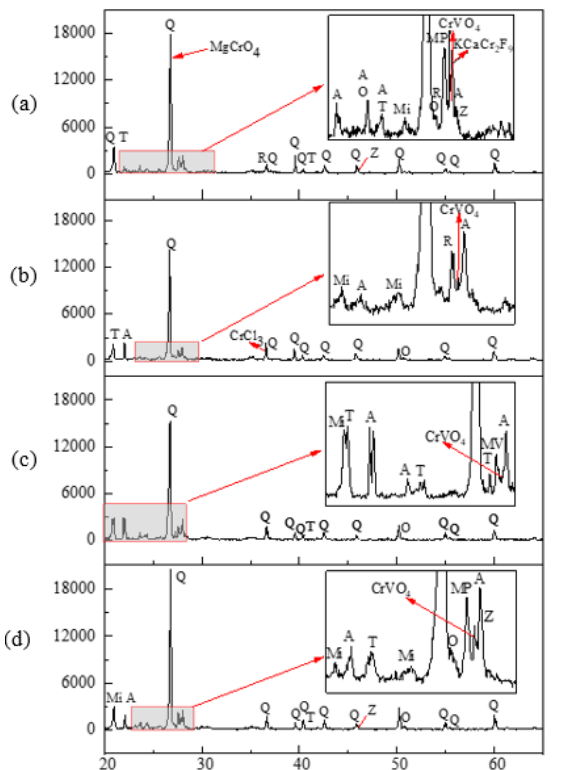
Figure 5. X-ray diffraction patterns of the soils before and after leaching by different acids. ( a ) Original soil, ( b ) soil leached by HCl, ( c ) soil leached by CA, ( d ) soil leached by OX.